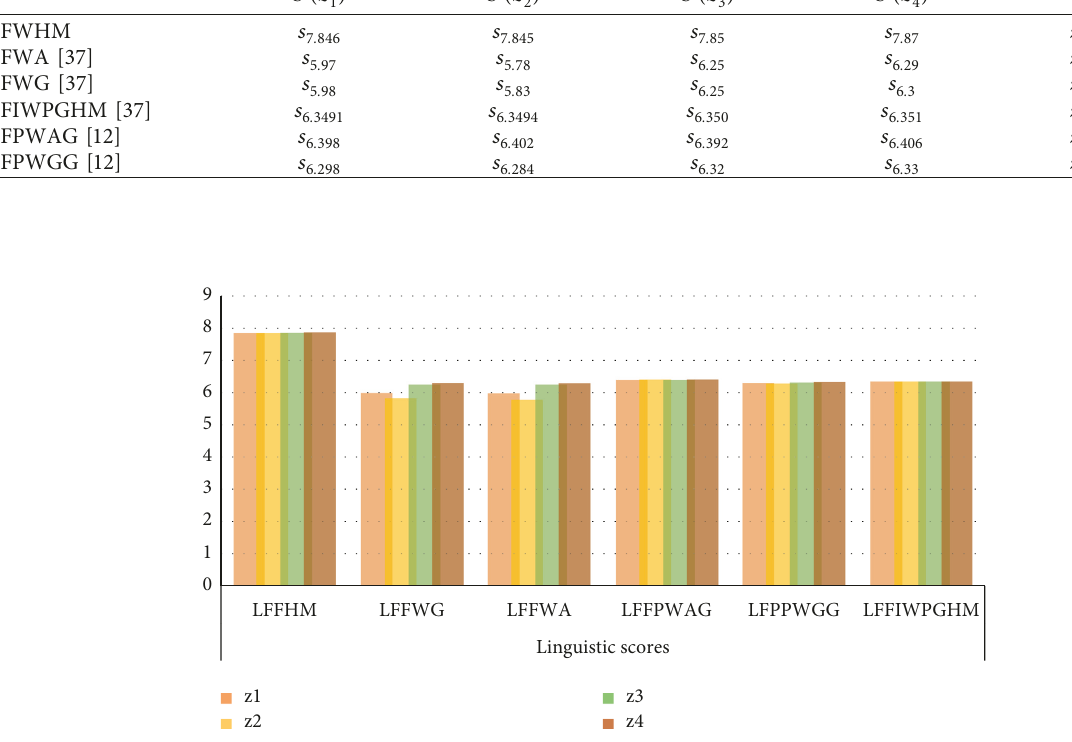
Table 22: Ranking results by different methods with LFFHM operator. Score function Methods